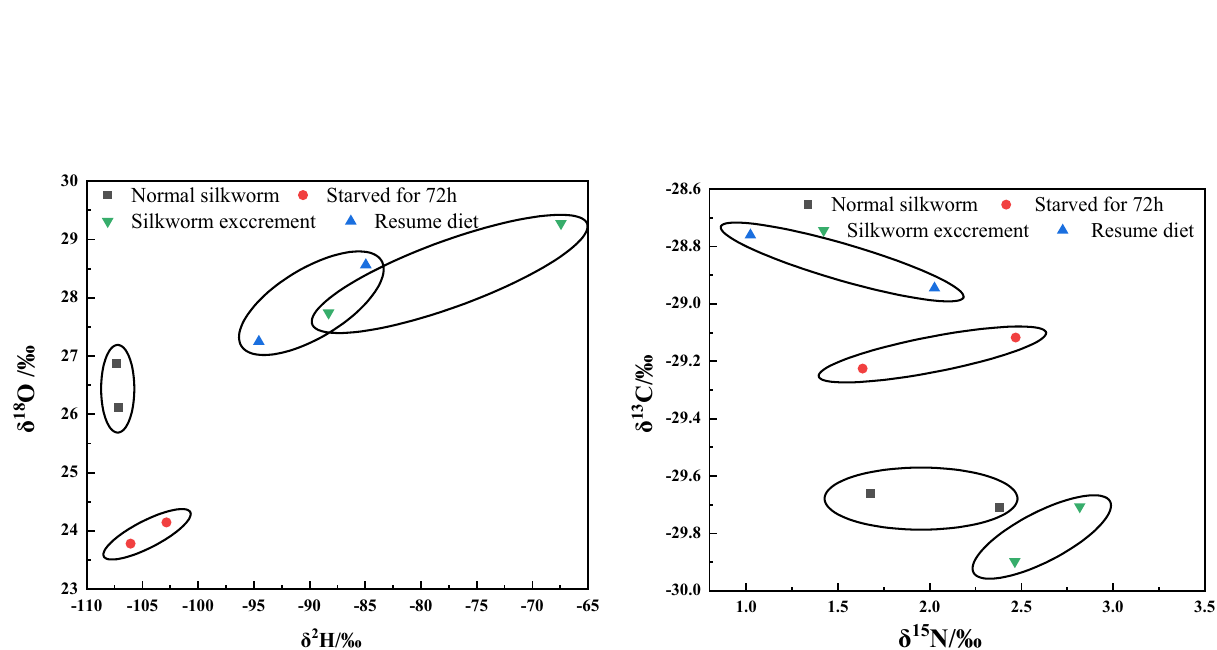
Figure 9. Distribution of stable isotopes of hydrogen, oxygen, carbon and nitrogen before and after